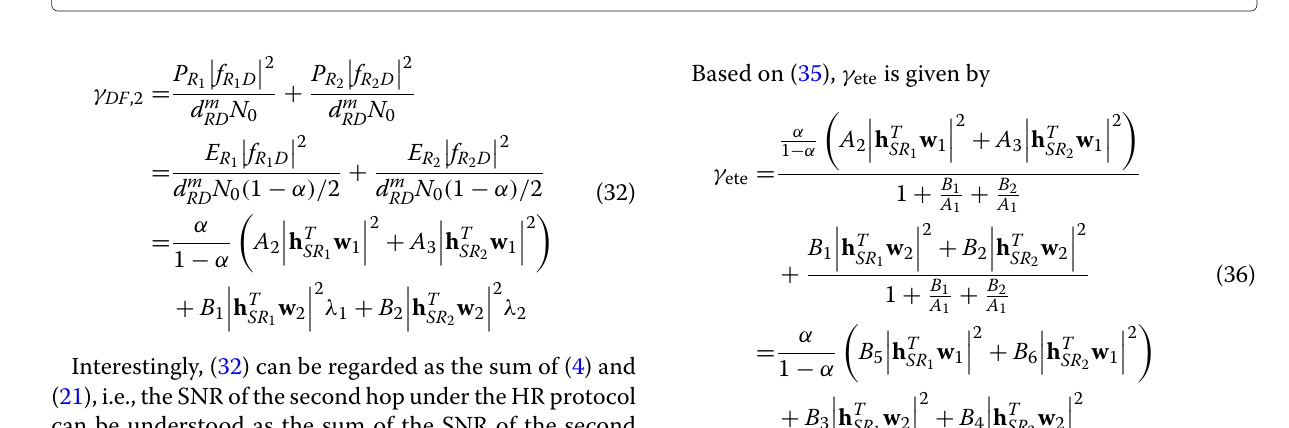
Fig. 5 Diagram of the HR